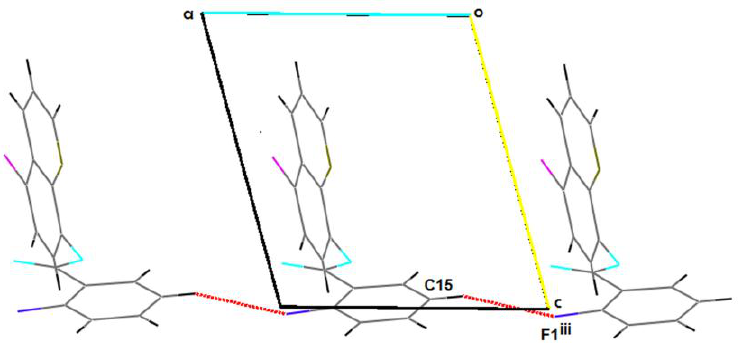
Table 2. Non-classical hydrogen and halogen bonding lengths [Å ] for compound 3 . Figure 2. Partial packing diagram showing the two-dimensional sheet network of molecules in the bc plane, the formation of which is governed by the occurrence of C–Cl…F halogen bonds and C-H…F hydrogen bonds, forming edge-fused R 2 2 (18) rings parallel to (100). Hydrogen bonds are depicted with dashed lines. (Symmetry code: (i) − x + 2,y − 1/2, − z + 3/2; (ii) − x + 2, − y + 1, − z + 2). Interactions on the (100) plane are complemented by other weak hydrogen bonds: The C15–H15 acting as a donor with respect to the F iii atom (see Figure 3 and Table 2). These interactions generate a chain of molecules growing along [001].